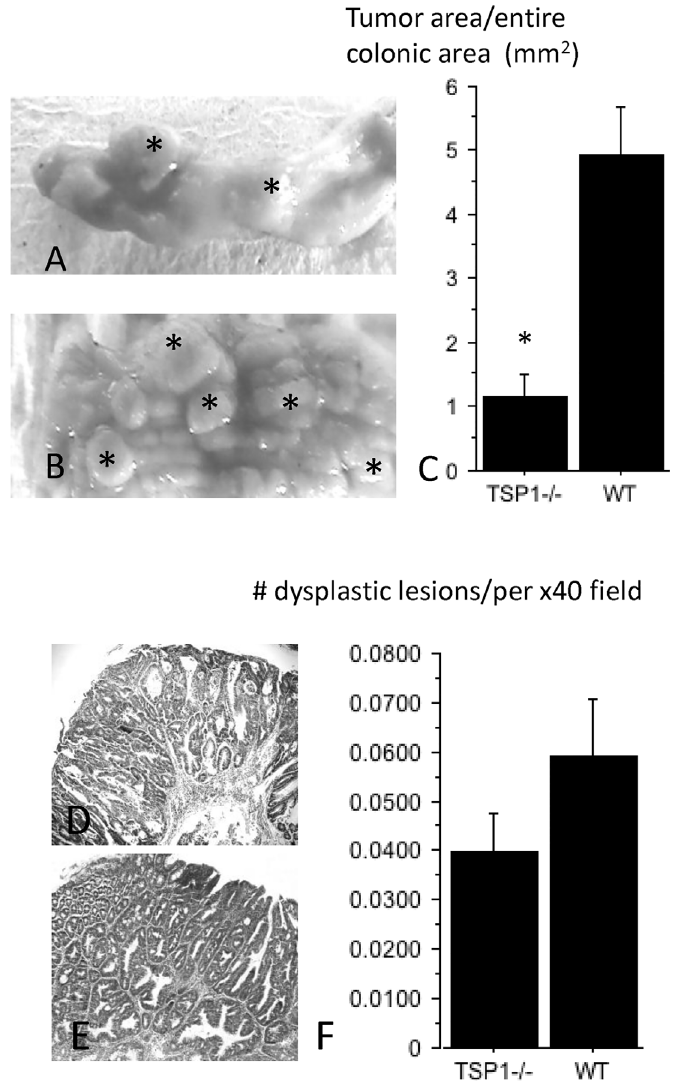
Fig 1. Gross and microscopic features of AOM/DSS tumors originated in WT and TSP-1 -/- colons. Tumors in TSP-1 -/- colons (A, asterisks) consisted of well-delimited polypoid lesions separated by wide areas of normal mucosa. WT tumors (B, asterisks) were grossly characterized by multiple coalescing tumors delimited by little intervening normal mucosa When the area containing tumors was compared with the entire colonic area of each mouse, the tumor burden was decreased in AOM/DSS-treated TSP-1 -/- versus WT mice (p = 0.0060), (C). All the microscopic dysplastic foci were analyzed in TSP-1 -/- (D) and WT colonic sections (E). No significant differences were observed in the number of dysplasic lesions detected by microscopic field (p = 0.14)